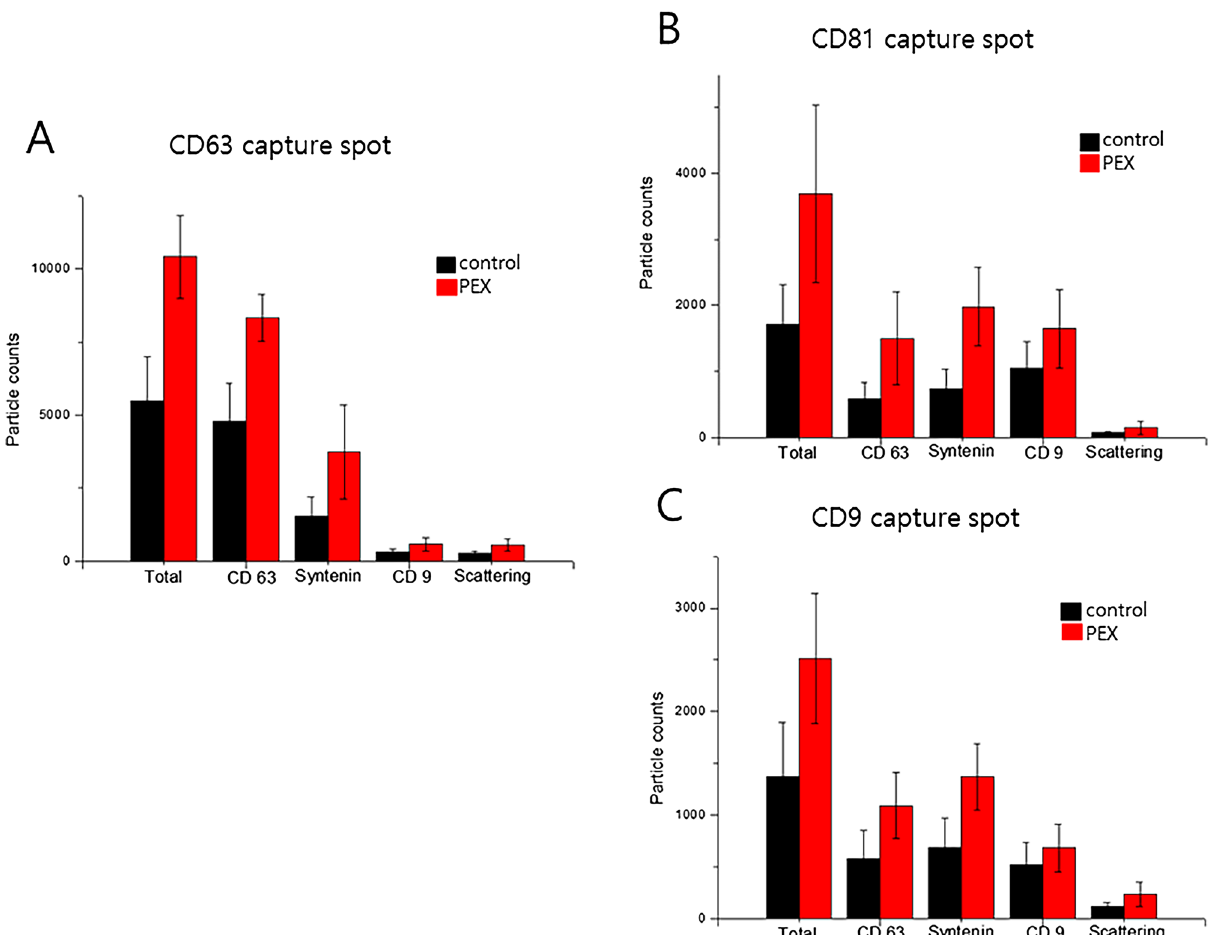
Figure 5. The number of exosome particles in grouped clinical data. Compared to the control subjects (black- colored in the bar graph), the numbers of the exosome particles in PEX patient AH samples (red-colored in the bar graph) were higher, with statistically significant differences. Capture spot CD63 ( A ), capture spot C81 ( B ), and capture spot CD9 ( C ).